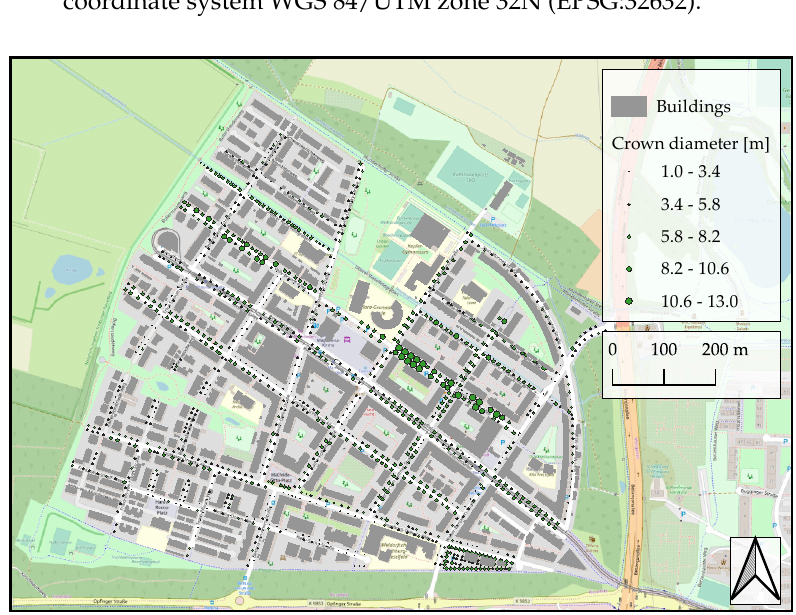
Figure 5. Study area showing the urban district Rieselfeld in Freiburg, Germany with urban trees and building shapes. (Basemap: © OpenStreetMap contributors, CC BY-SA, Trees and Buildings: © City of Freiburg i. Br., surveyor’s